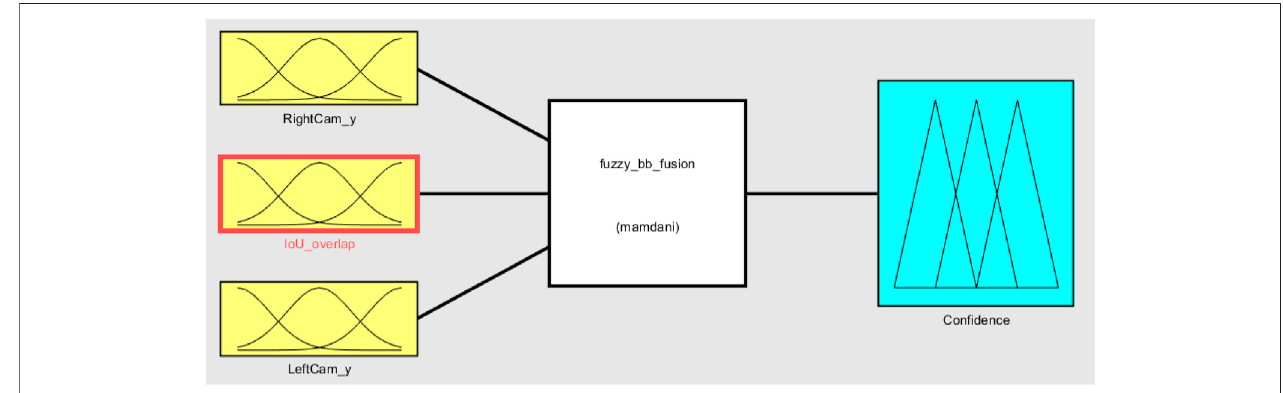
FIGURE 8 | Basic con fi guration of the fuzzy